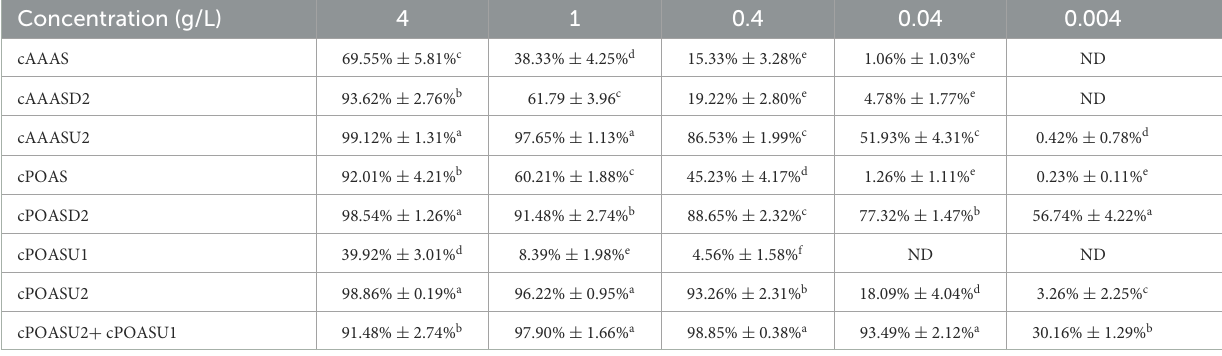
TABLE 1 Lead clearance activities of fractions in the purification step under different concentrations.